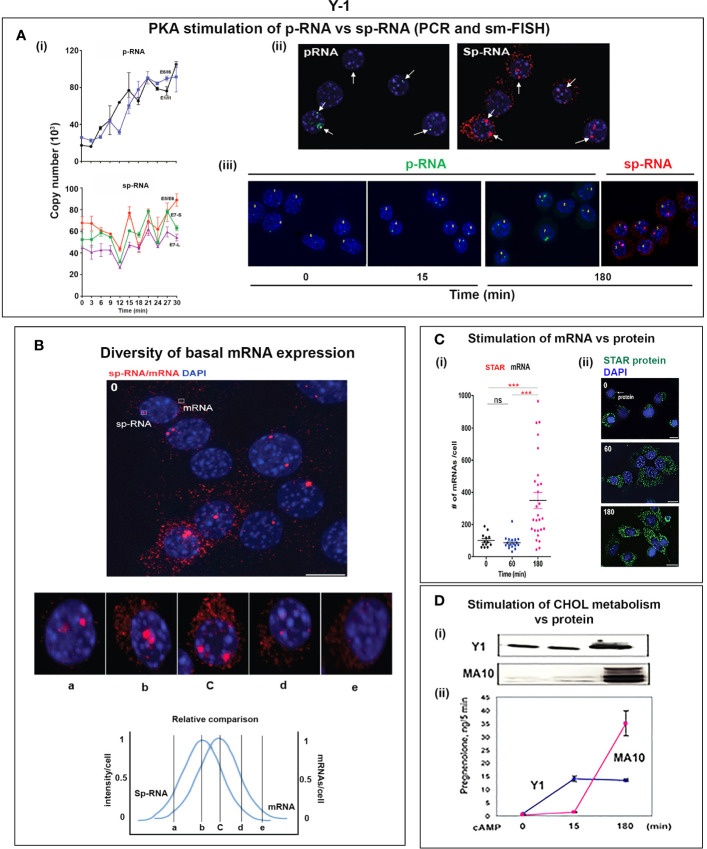
Y-1 cells show heterogeneous basal activation and acute, sustained loci activation with slow splicing and protein translation. (A) (i). Time course (qPCR copy number) for stimulation of STARD1 p-RNA (intron1 vs. intron6 (UPPER) and spRNA/mRNA (exon5/exon6; 3’UTR early (S) and extended (L) (LOWER). (ii). sm-FISH basal expression of same 5 cells probed with p-RNA and sp-RNA. The data demonstrate little relationship between p-RNA or sp-RNA at loci and mRNA in cytoplasm. (iii). p-RNA increases between 0 and 15 min but remain similar at 180 min. sp-RNA/mRNA at 180 min increase in a number of cells, with high expression in nucleus and cytoplasm. (B) Basal sp-RNA heterogeneity at high sensitivity captures both loci and mRNA. Varying proportions of locus activation and mRNA (a, b, c, d) may reflect different stages of a cycle comprising locus activation, mRNA processing, export, locus inactivation, mRNA turnover. (C) (i). Cytoplasmic mRNA particles counted from each of 30 adjacent cells (particle counts/cell) compared to protein expression (cell fluorescence): half the cells do not express detectable cytoplasmic mRNA. Delayed increase in cytoplasmic mRNA occurs from 60-180 min. ***p<.001; ns, not significantly different. (ii). Proportion of cells with high translated protein in mitochondria increases progressively 0–180 min. (D) (i). Total protein measured by immunoblot only increases after 15 min in Y-1 cells. (ii). Activity is fully increased in the first 15 min. MA10 activity increases only after 15 min and in parallel with increased protein accumulation. Portions of this figure were previously published (10, 145, 150).